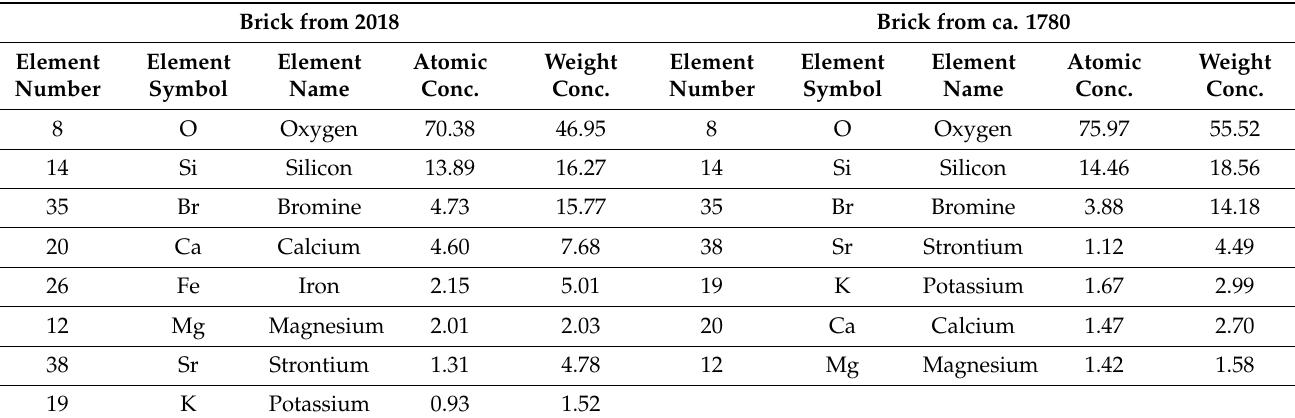
Table 1. Stoichiometry results.